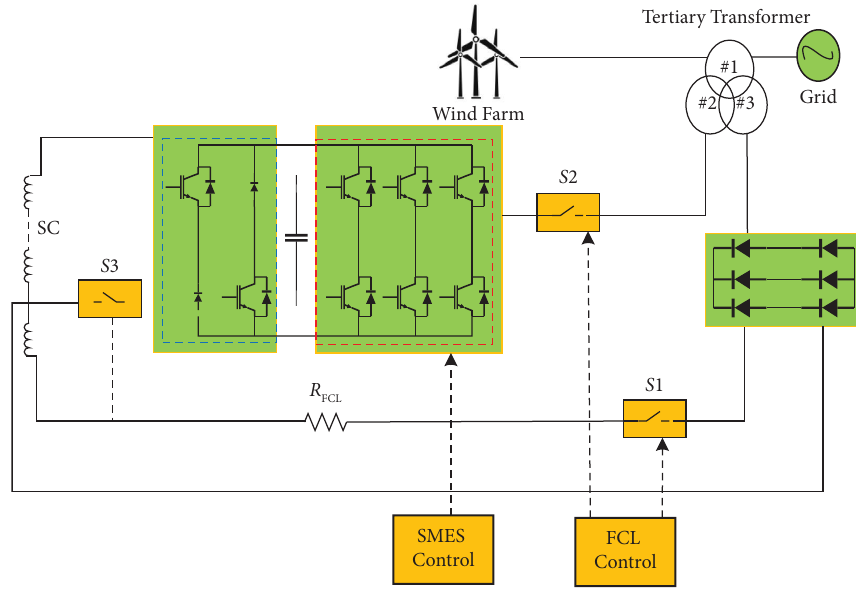
Figure 16: Te aggregation of (SFCL and SMES) in one